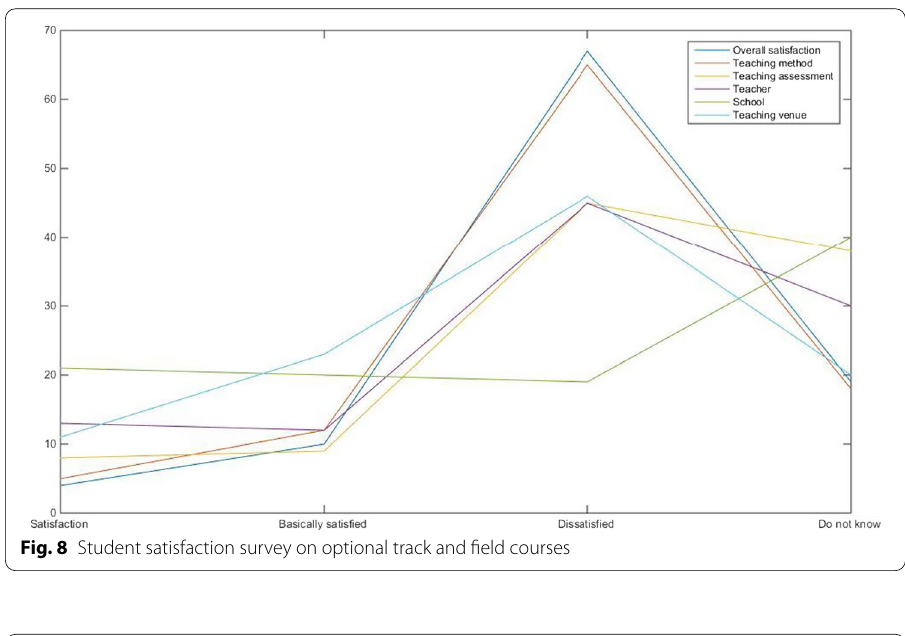
Fig. 8 Student satisfaction survey on optional track and field courses